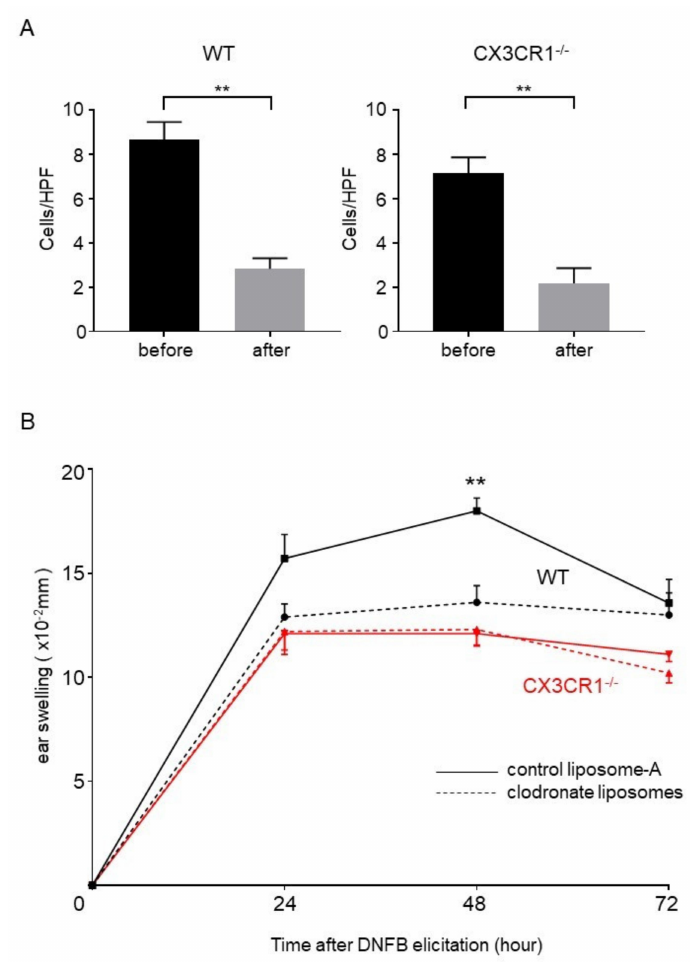
Figure 5. Depletion of dermal macrophages in wild-type mice attenuates CHS to the same extent as CX3CR1 − / − mice. ( A ) The number of F4 / 80 + cells per high power field in the skin samples of wild-type mice and CX3CR1 − / − mice before and after injection of clodronate liposomes. All values represent the mean ± SEM. n = 6. ** p < 0.01 by Mann–Whitney U-test. ( B ) Challenge by DNFB was performed one day after intradermal injection of clodronate liposomes or control liposomes into wild-type mice or CX3CR1 − / − mice. Ear swelling was measured before elicitation and at 24, 48, and 72 h after elicitation and the changes in ear thickness from baseline measurement were presented. All values represent the mean ± SEM. n = 7–10. ** p < 0.01 by Kruskal–Wallis test and Steel–Dwass